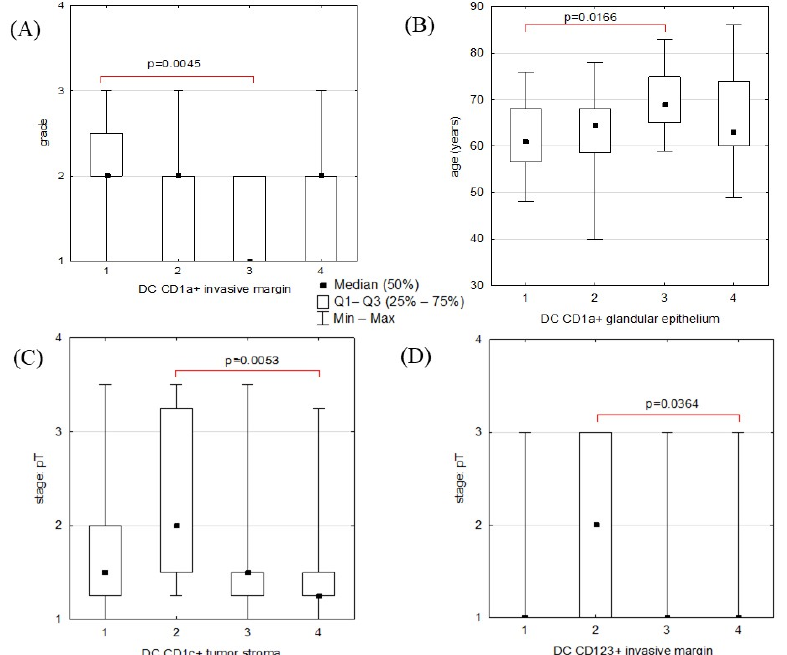
Figure 7. ( A ) Distribution of pathological grade scores between four groups of ECs distinguished based on the amount of DC CD1a+ present in the invasive margin; ( B ) median age (years) between four groups of ECs distinguished based on the amount of DC CD1a+ present in the glandular epithelium; ( C ) distribution of pathological stage: pT scores between four groups of ECs distinguished based on the amount of DC CD1c+ present in the stroma; ( D ) distribution of pathological stage: pT scores between four groups of ECs distinguished based on the amount of DC CD123+ present in the invasive margin. This graph shows all comparisons between the number of different DCs and clinicopathological features of ECs that were statistically significant (Table 4). The statistical analysis was performed using the Kruskal–Wallis ANOVA test (followed by the post hoc Dunn test). ECs groups significantly different in the selected dependent variable are linked by brackets captioned with the p -value calculated in the post hoc Dunn test. p < 0.05 was considered statistically